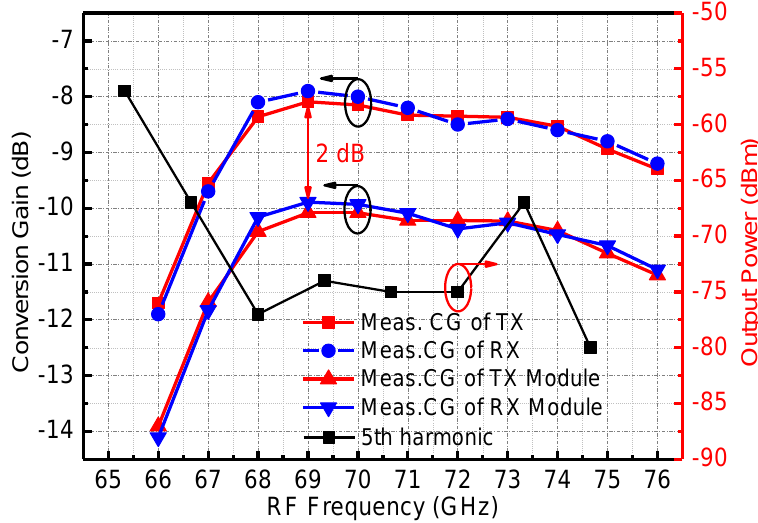
Figure 14. Measured conversion gain of the RF channel emulator and the module.